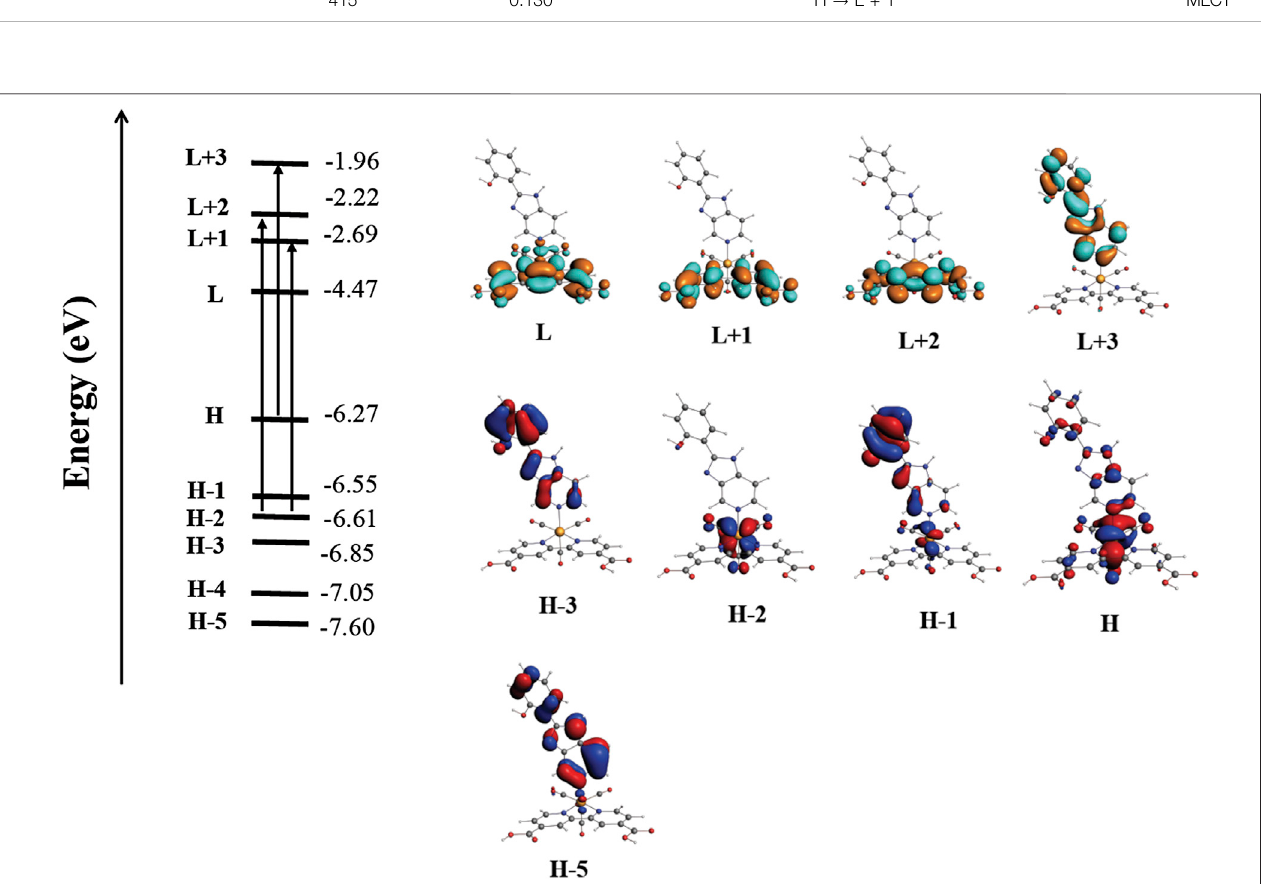
FIGURE 3 | Qualitative molecular orbital diagram showing the most important electronic transitions involved in the absorption spectra of fac -[Re(CO) 3 ( deeb ) B2 ] + .